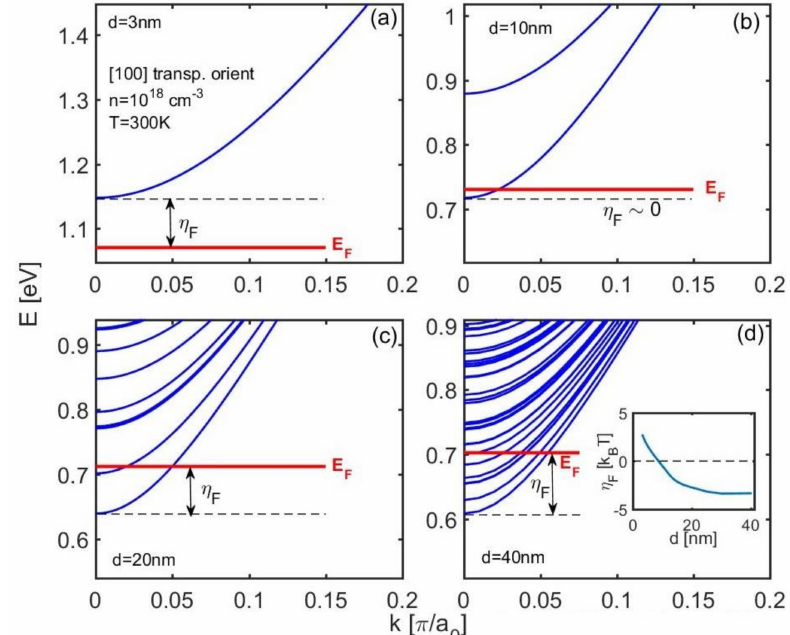
Figure 1. Electronic bandstructures for [100] InAs nanowires of diameters ( a ) d = 3 nm, ( b ) d = 10 nm, ( c ) d = 20 nm, and ( d ) d = 40 nm. The position of the Fermi level E F for carrier density n = 10 18 / cm 3 at room temperature is indicated. The di ff erence of the Fermi level from the band edges η F = ( E C − E F ) / k B T , which determines the Seebeck coe ffi cient, is indicated as well. The inset of ( d ) shows η F versus the NW diameter.